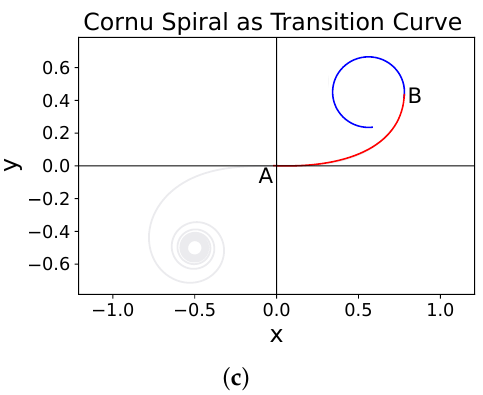
Figure 9. Transition Curve. ( a ) Point A is shifted back to A’ which is the starting point of the transition curve shown in blue. There is a gradual increase in curvature so that there is no sudden kink or jerk. ( b ) Cubical parabola as a transition curve. ( c ) Cornu Spiral or clothoid as a transition